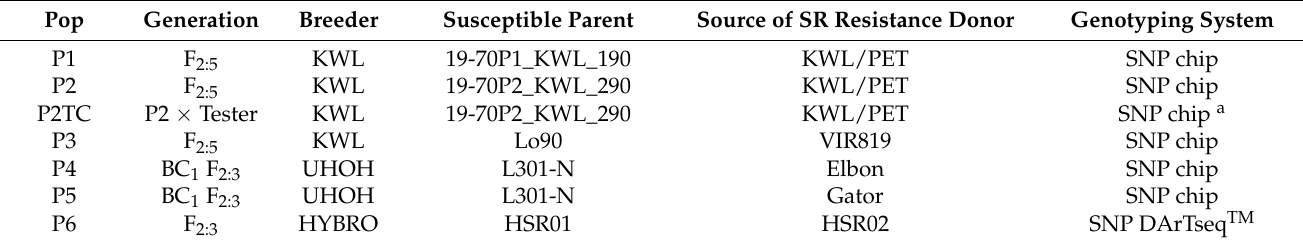
Table 1. Generation, breeder, origin and genotyping system for six populations (P1-P6) and one testcross population used in this study.